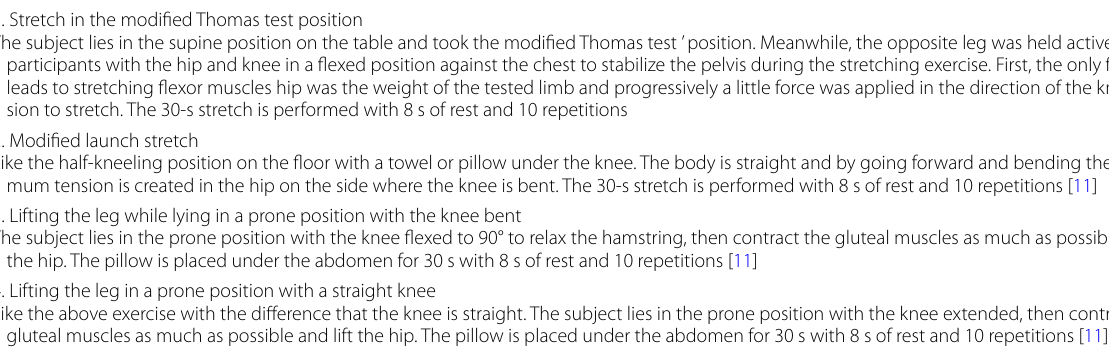
gluteal muscles as much as possible and lift the hip. The pillow is placed under the abdomen for 30 s with 8 s of rest and 10 repetitions